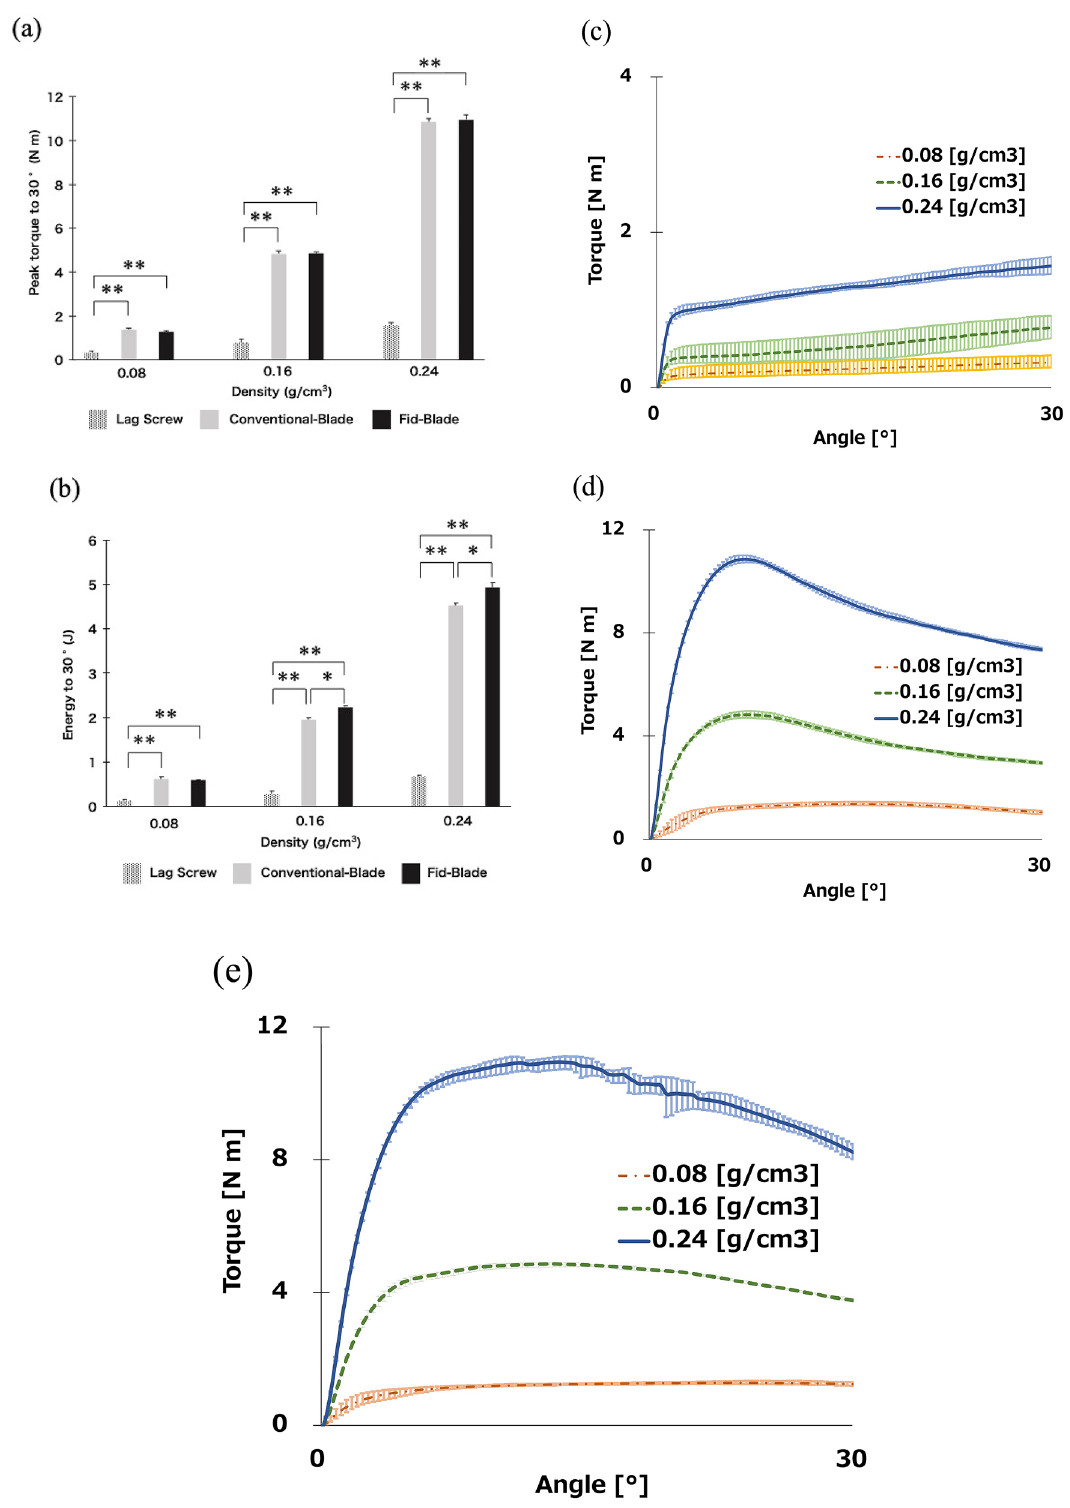
Figure 3. Torsion test. ( a ) Mean peak torque to achieve 30° rotation. ( b ) Mean energy to achieve 30° rotation. * P < 0.05. ** P < 0.01. ( c – e ) Mean torque–angle curves ( c ) Lag Screw. ( d ) Conventional-Blade. ( e )